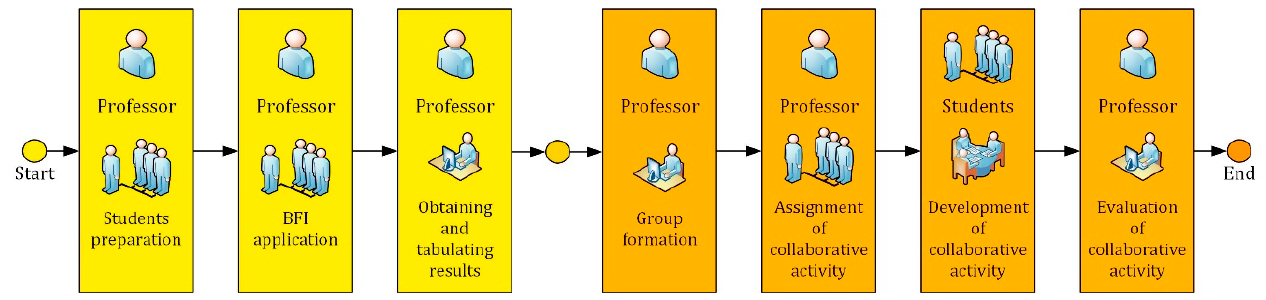
Figure 7. Class activity diagram.